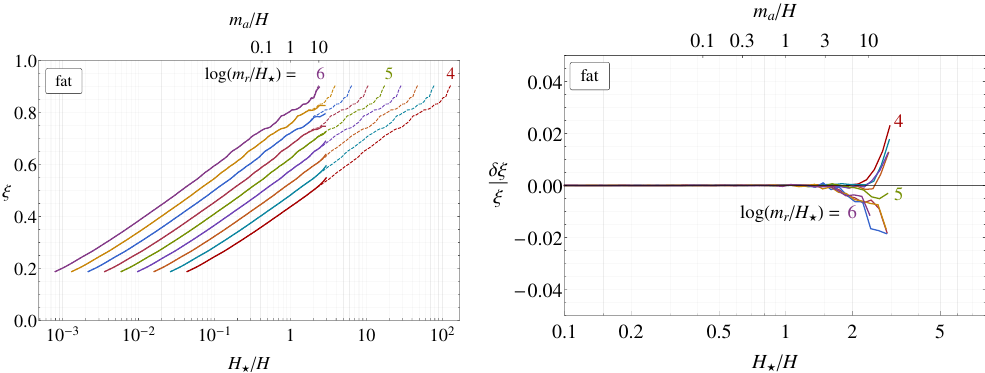
/ m (cid:63) ) (solid lines), and for m = 0 throughout a r a ) , and ξ m a = 0 m a = 0 = 0 throughout. For all values of log (cid:63) a